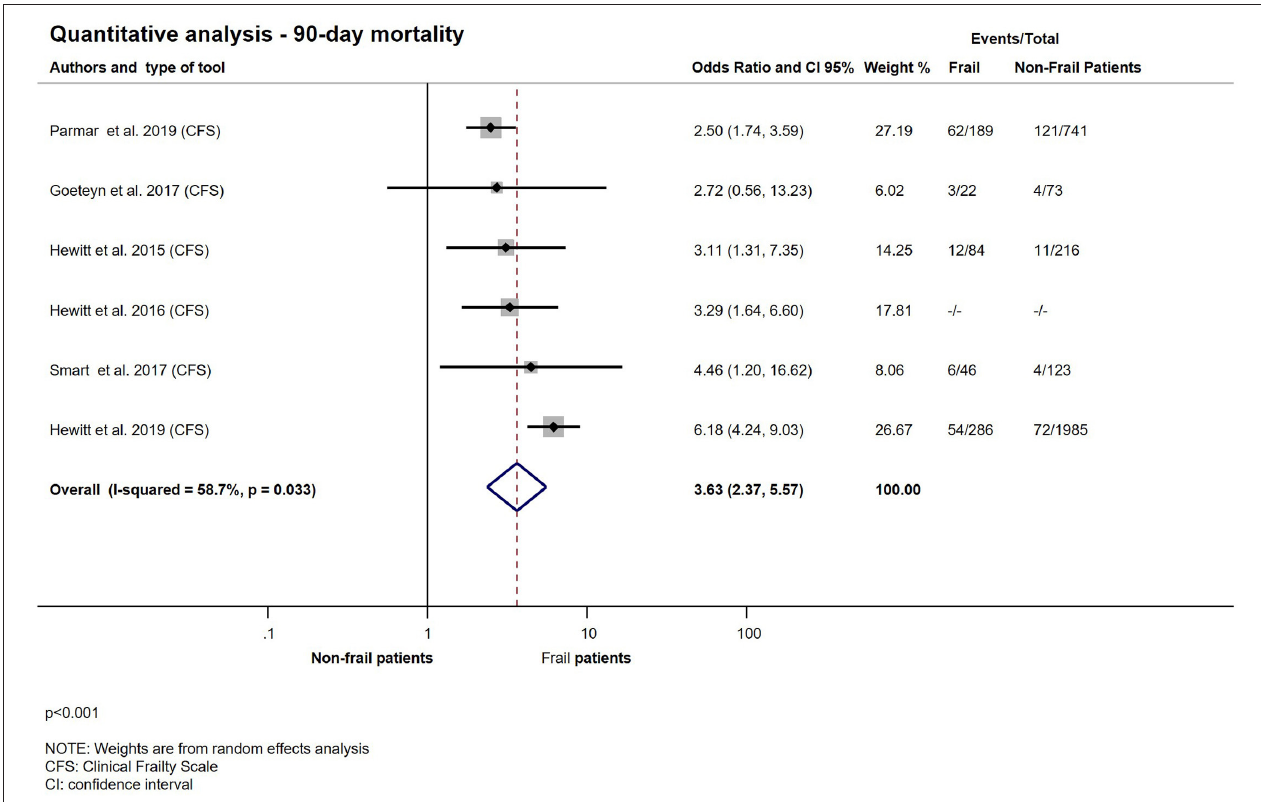
FIGURE 6 | Quantitative analysis − 90-day mortality for emergency surgical patients living with frailty compared to non-frail patients. Frail patients (CFS > 4) have higher odds of 90-day mortality (OR: 3.63; CI: 2.37–5.57). Crude OR (23) was pooled with the ORs calculated from raw data. Note that heterogeneity was moderate.